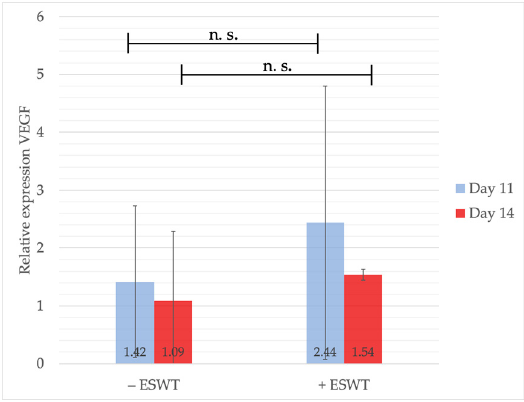
Figure 7. Gene expression analysis of VEGF via qPCR. The analysis could show a non-significant increase of VEGF one day after ESWT compared to the control group. At EDD-14 no effect of ESWT regarding VEGF expression was detectable. Shown are means ± SD, n.s. = not significant. Mann-Whitney test, not normally distributed.